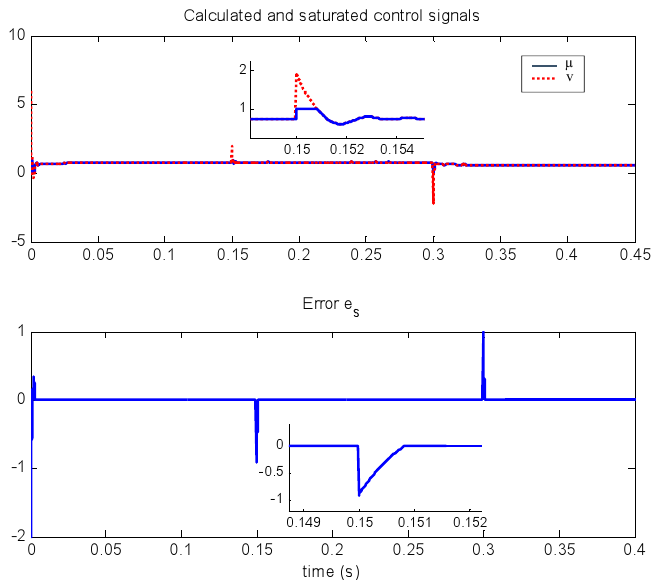
Figure 9. Computed control signal v ( t ) , the applied value µ ( t ) , and the error e s ( t ) in the presence of a time-varying reference.